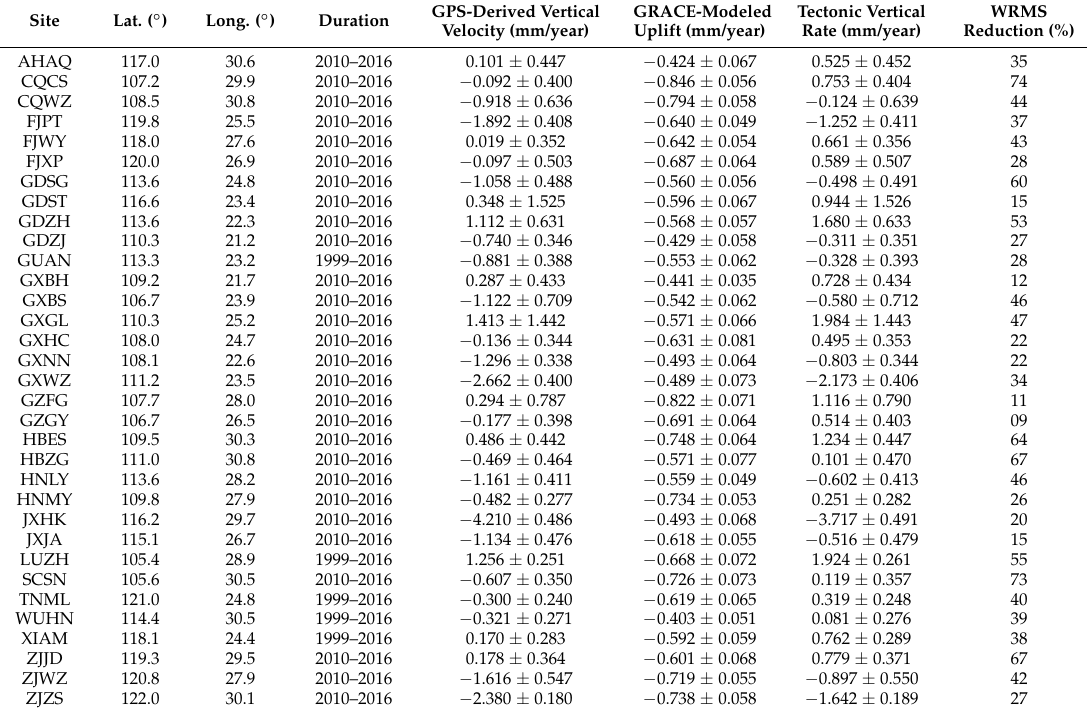
Table 1. The information of GPS stations with their vertical velocities, and GRACE-modeled uplift rates.